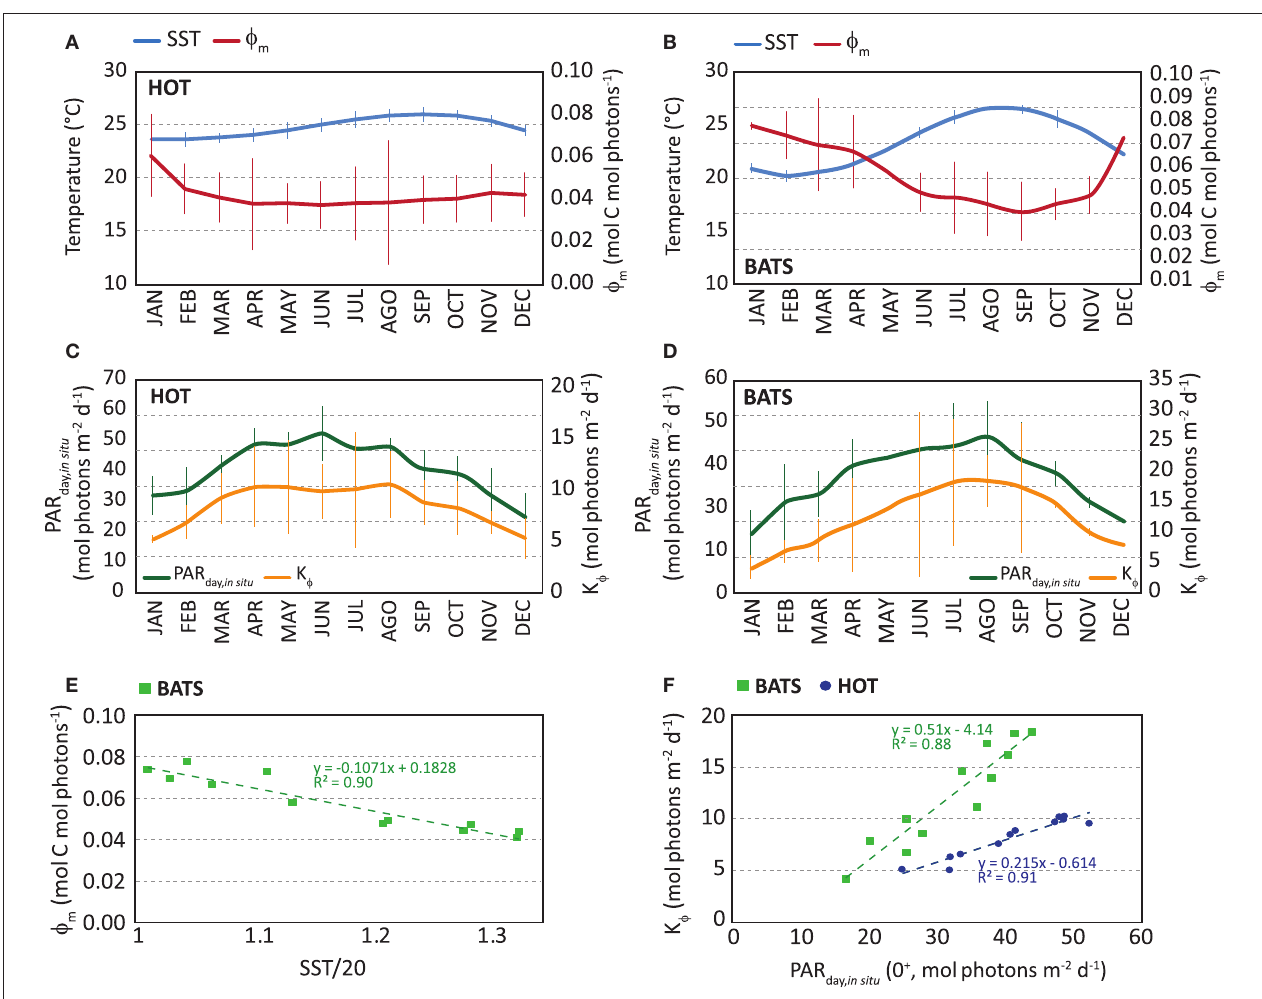
FIGURE 5 | Monthly median of in situ maximum quantum yield of photosynthesis ( φ m , in mol C mol photons − 1 ) in red and in situ monthly median of sea surface temperature (SST, in ◦ C) in blue: (A) at HOT and (B) at BATS. Error bars represent standard deviation. Monthly median of in situ K φ (in mol photons m − 2 d − 1 ) in yellow and in situ monthly median of PAR day, in situ (in mol photons m − 2 d − 1 ) in green: (C) at HOT and (D) at BATS. Error bars represent standard deviation. (E) In situ monthly median φ m as a function of monthly SST at BATS and (F) in situ monthly median K φ as a function of PAR day, in situ (0 + ). In graph and (F) results of both stations are displayed together, where HOT is represented by blue circles and BATS as green squares.